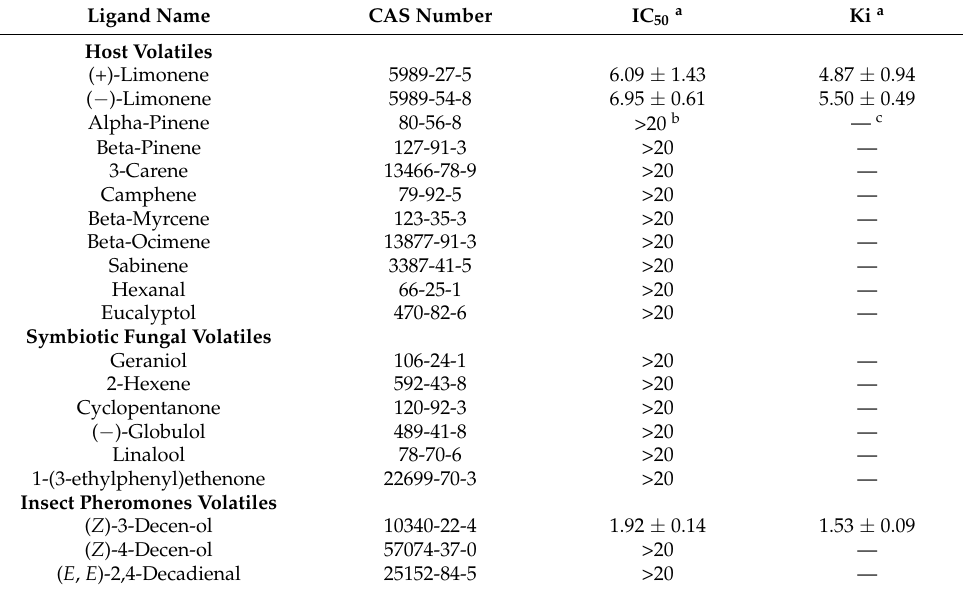
Figure 5. Binding curves for host volatiles ( A ), symbiotic fungal volatiles ( B ) and insect pheromone volatiles ( C ) to SnocOBP9. The ligand names are shown on the right side in the curves. The binding data are listed in Table 3. Table 3. Binding data for different types of volatiles to SnocOBP9.